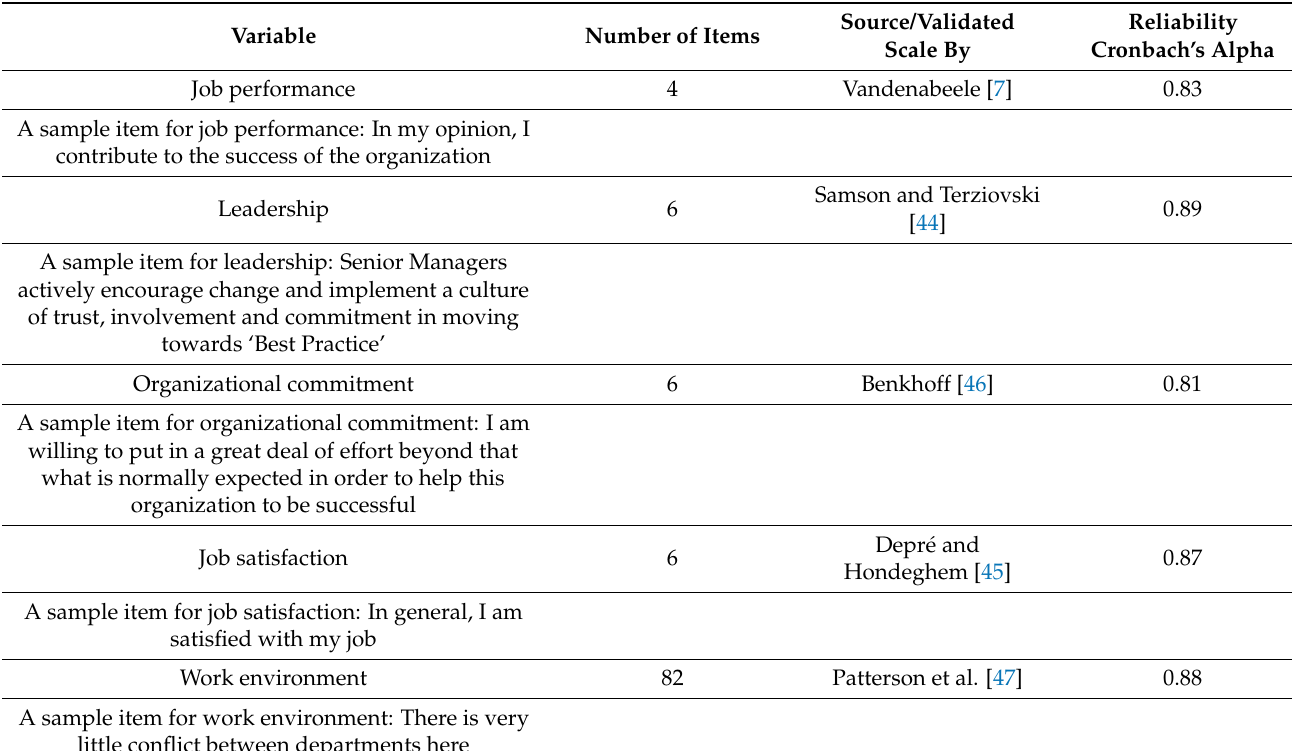
Table A1. Sources of the validated scales and Cronbach’s alpha reliability results in the current study.